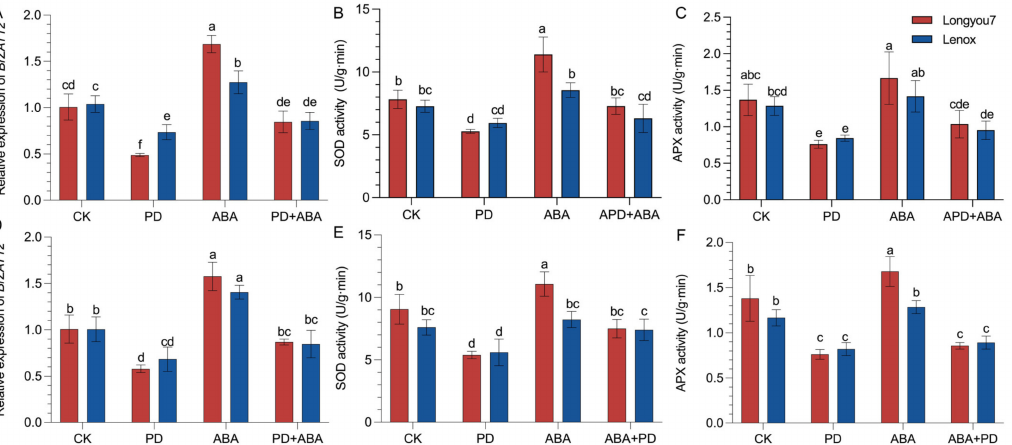
Figure 8. Expression of BrZAT12 and activities of SOD and APX in B. rapa under different treatments. ( A – C ) Room-temperature treatment and ( D – F ) low-temperature treatment. a–e represent significant differences between treatments at p ≤